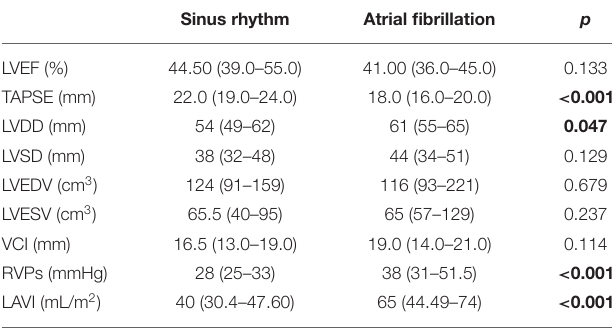
TABLE 2 | Clinical characteristics of patients in the AF and non-AF groups after PS matching.